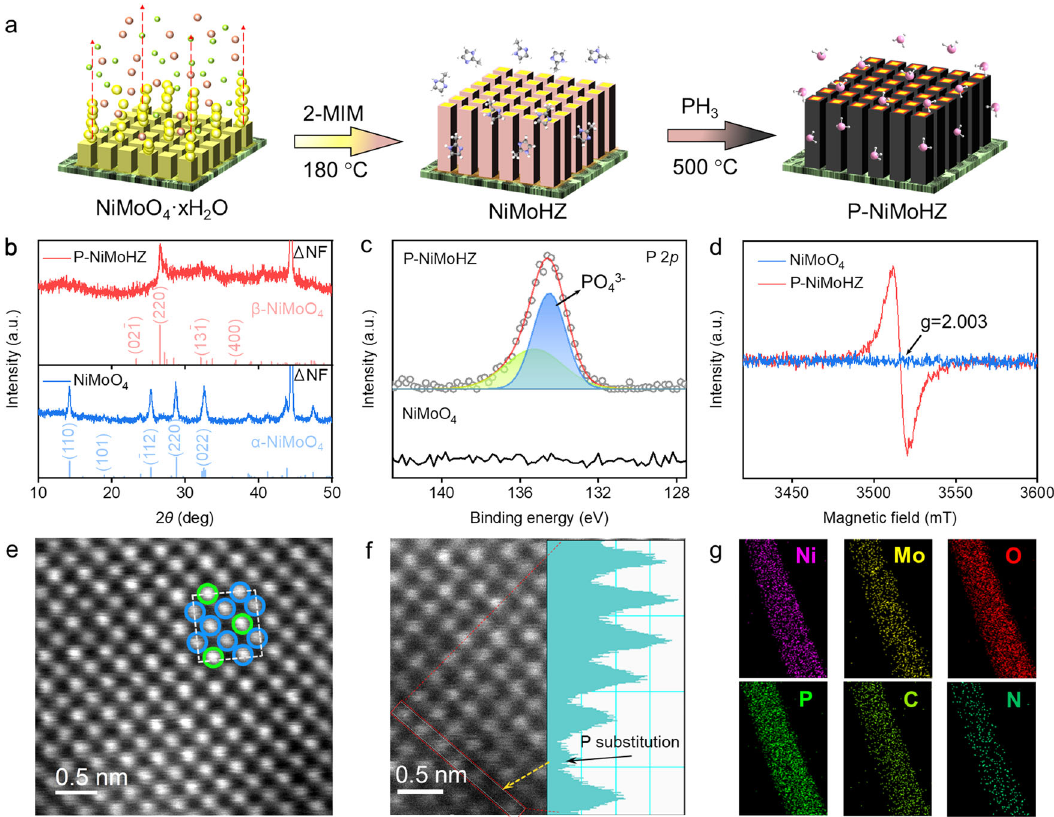
Fig. 1 Design and structure characterization of α -NiMoO 4 and β -NiMoO 4 . a Schematic illustration of the preparation process for P-NiMoHZ. The light green, light red, and yellow balls represent Ni 2 + cations, MoO 2 - anions, and NiMoO 4 crystals, respectively. The ball-and-stick models around nanorod 4 arrays are 2-MIM (middle) and PH 3 (right) molecules. b XRD patterns of P-NiMoHZ and NiMoO 4 . c XPS spectra of P 2 p . d EPR spectra of P-NiMoHZ and NiMoO 4 . e HAADF-STEM image of P-NiMoHZ. The blue and green circles represent Mo and Ni atoms, respectively. f HAADF-STEM image of P-NiMoHZ with an intensity pro fi le corresponding to the red line. g HAADF-STEM elemental mappings of